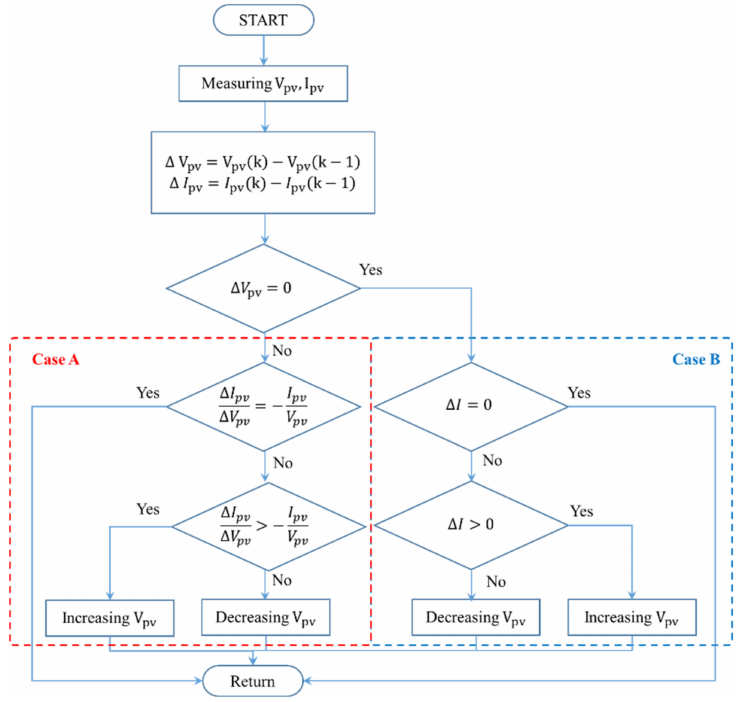
Figure 14. Flowchart of the IncCond